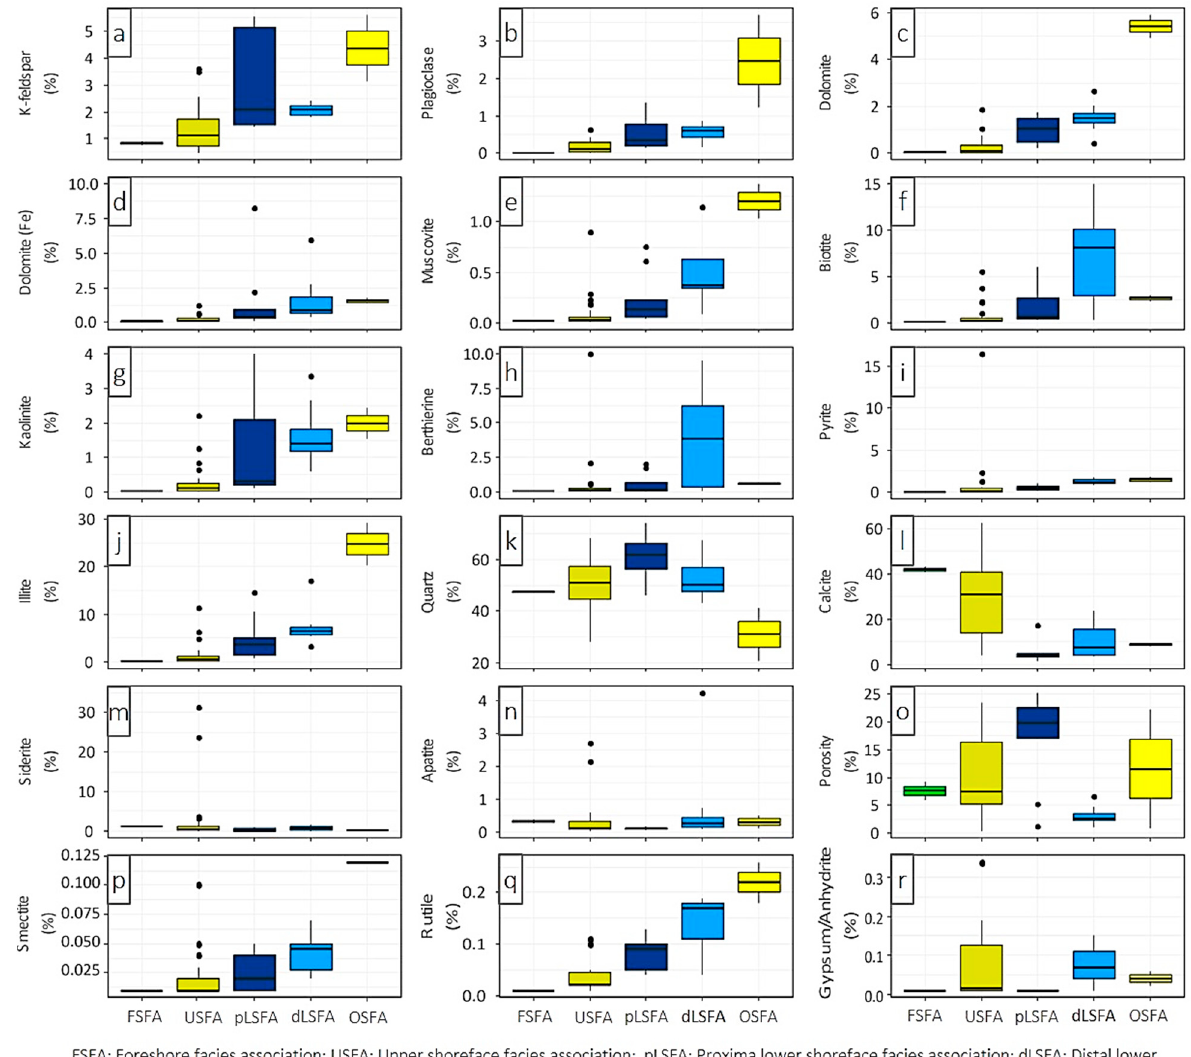
Figure 12. Boxplots relating SEM-EDS mineralogy to facies association. K-feldspar, plagioclase feldspar, dolomite, Fe-dolomite, muscovite, biotite, kaolinite, berthierine, pyrite and illite ( a – j ) increase basinward. Quartz ( k ), siderite ( m ), apatite ( n ), porosity ( o ) and gypsum/anhydrite ( r ) do not show a clear relationship with facies association. Smectite ( p ) and rutile ( q ) show an increase basinward from foreshore to offshore facies association. In contrast, calcite ( l ) shows a decrease basinward.